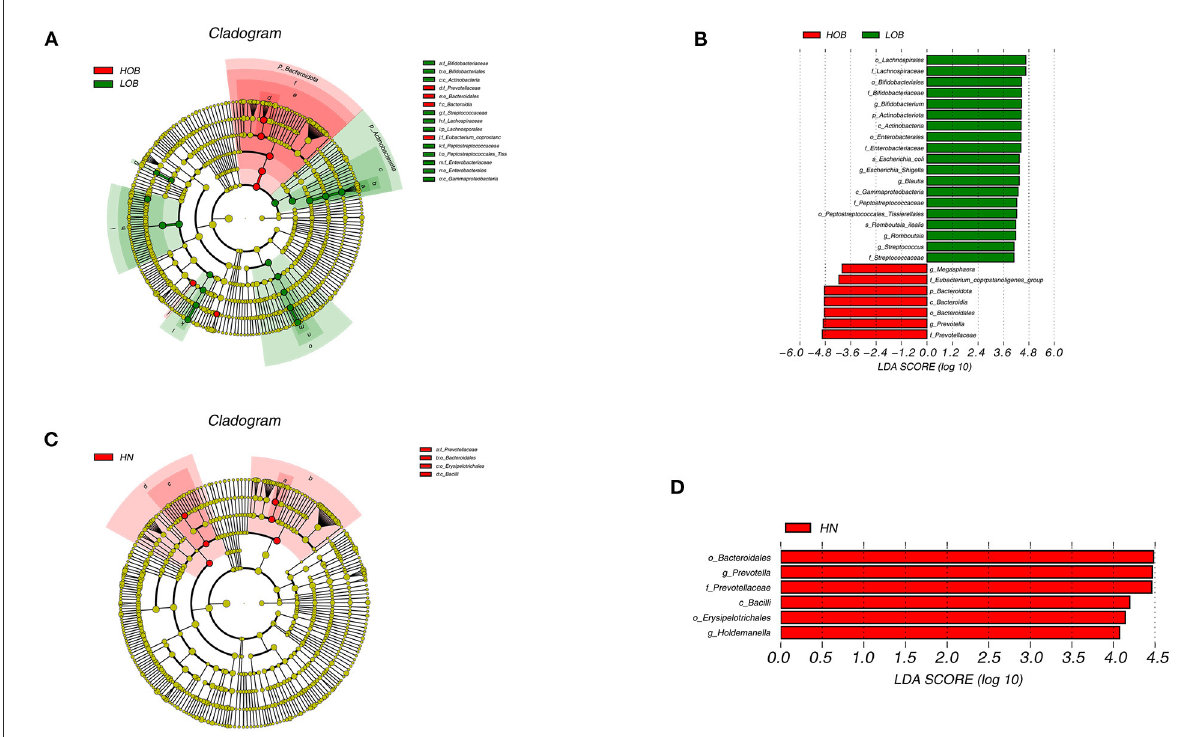
FIGURE5 Cladogram based on LEfSe analysis showing the different abundance bacteria between two groups. Comparison between high-altitude obese children (HOB) and low-altitude obese children (LOB) (A) . Comparison between high-altitude normal weight children(HN) and low-altitude normal weight children (LN) (C) , with a linear discriminant analysis (LDA) threshold of 4 (B,D) . The bacteria with significantly different abundance at different taxonomic levels among groups were highlighted by colored circles and shadings.